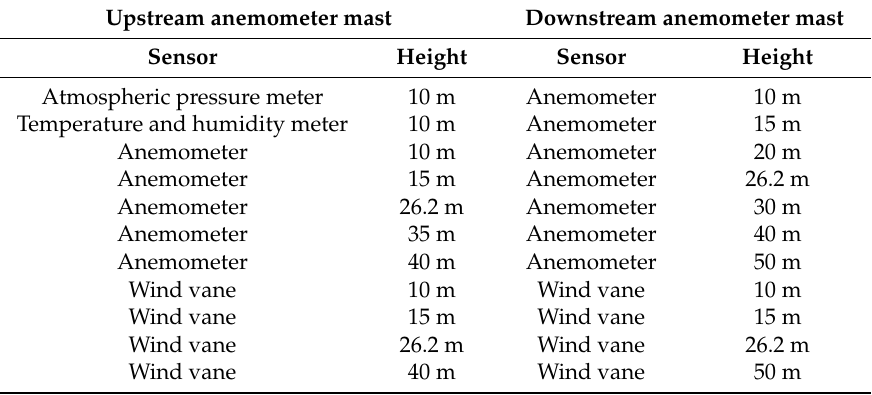
Table 2. Distributions of anemometers and wind vanes on the anemometer mast. Upstream anemometer